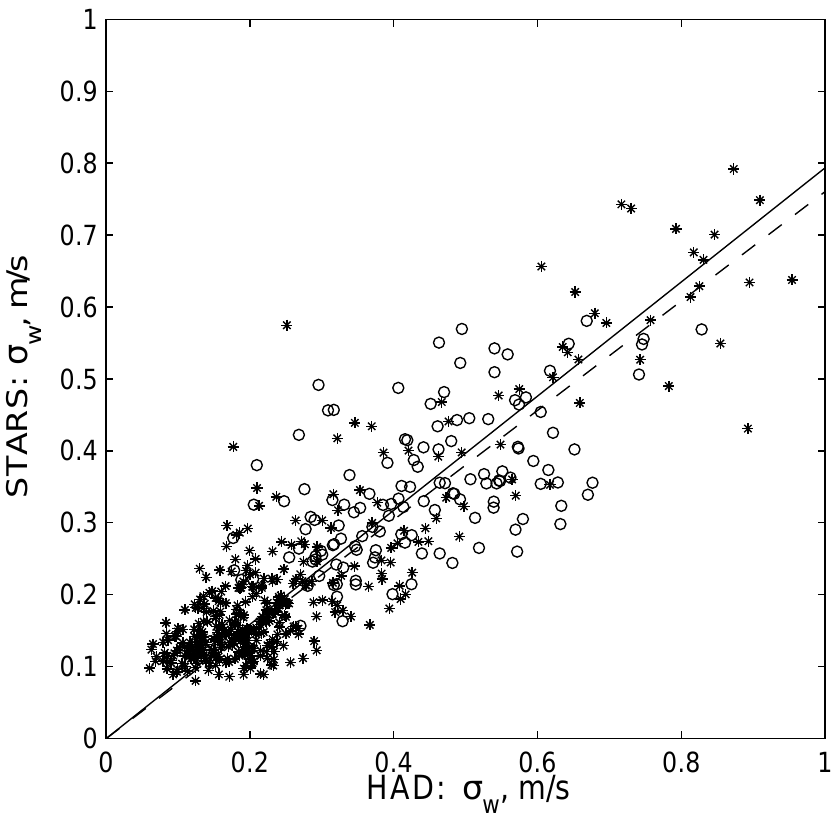
Fig. 10. Comparison of the STARS and HAD-produced standard deviation of the vertical turbulent velocity at height from 5km to 11km above the MUR on 24 April 2002 at 19:30:00–22:00:00 LT. (1) SNR ≥ 3dB: the results are shown by asterisks and solid lines. s = 0 . 79, e = 0 . 06m/s. (2) SNR < 3dB: the results are shown by circles and dashed lines. s = 0 . 76, e = 0 . 09m/s.